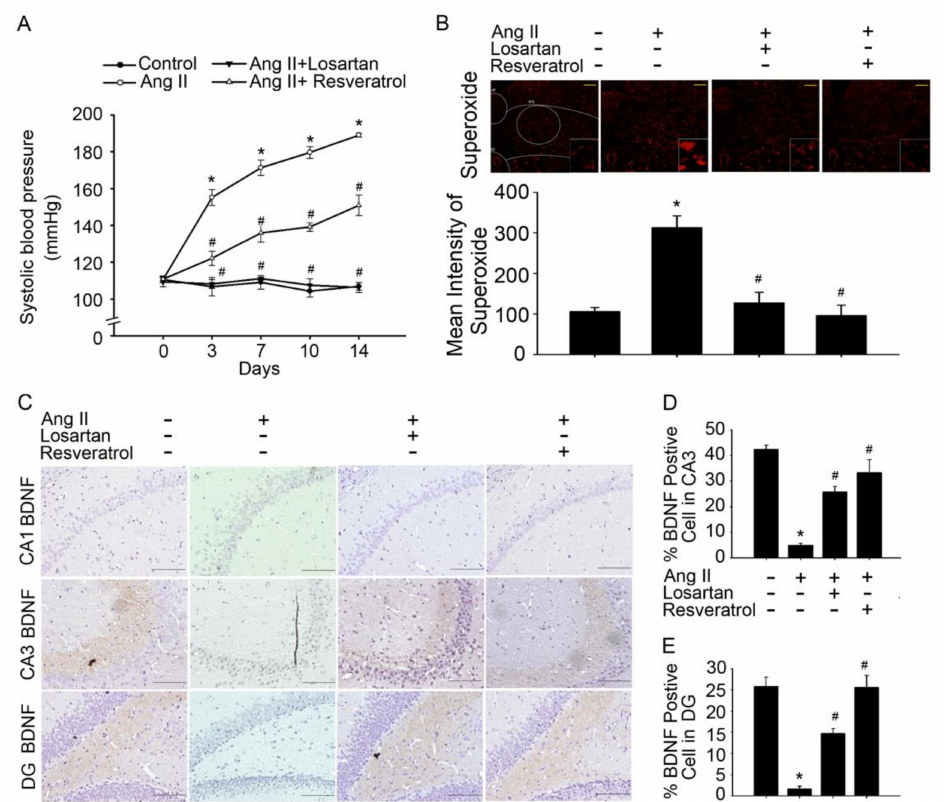
Figure 1. Downregulation of BDNF levels was associated with increased superoxide expression in rats with Ang-II-induced early Alzheimer’s disease (AD). ( A ) Time course of systolic blood pressure (SBP) after intracerebroventricular administration of angiotensin II (Ang-II) for two weeks. The filled circles ( ) represent the Wistar Kyoto (WKY) group, the open circles ( ) represent the Ang-II group, (cid:35) the inverted filled triangles ( (cid:72) ) represent the Ang-II + losartan group, and the open triangles ( ∆ ) represent the Ang-II + resveratrol group. SBP was measured on Days 0, 4, 7, 11, and 14. The data are presented as the mean ± standard error of the mean (SEM); n = 6. * p < 0.05 vs. the WKY and # p < 0.05 vs. the Ang-II group. ( B ) Confocal microscopy analysis of DHE-treated brain sections in the nucleus tractus solitarius (NTS) after treatment with losartan or resveratrol. Bar graph showing the superoxide production ratio after treatment with Ang-II and/or losartan or resveratrol. Note the significant decrease in Ang-II-induced superoxide production after the administration of losartan or resveratrol. (C) In situ qualitative analysis of BDNF-immunopositive cells in the hippocampus of AD model rats. Scale bar, 200 mm. ( D , E ) Bar graph showing BDNF-expressing cells after treatment with Ang-II and/or losartan or resveratrol. Note the significant increase in Ang-II-induced BDNF production after the administration of losartan or resveratrol. The percentage of BDNF-positive cells was determined by counting the BDNF-expressing cells in each hemisphere of the hippocampus (CA1 and CA3) at × 200 magnification. These values were divided by the total number of cells in the same paraffin section. BDNF, brain-derived neurotrophic factor; DG, dentate